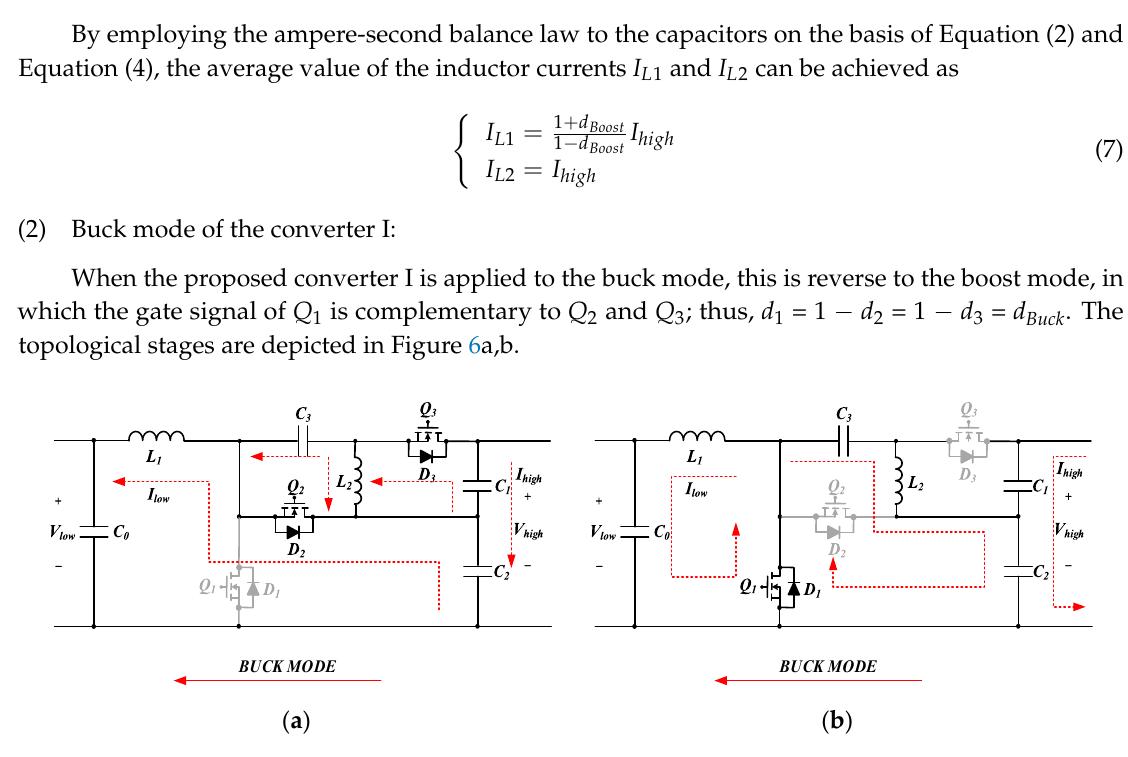
Figure 6. Topological states of converter I in buck mode. ( a ) [ t 0 –t 1 ]. ( b ) [ t 1 –t 2 ].